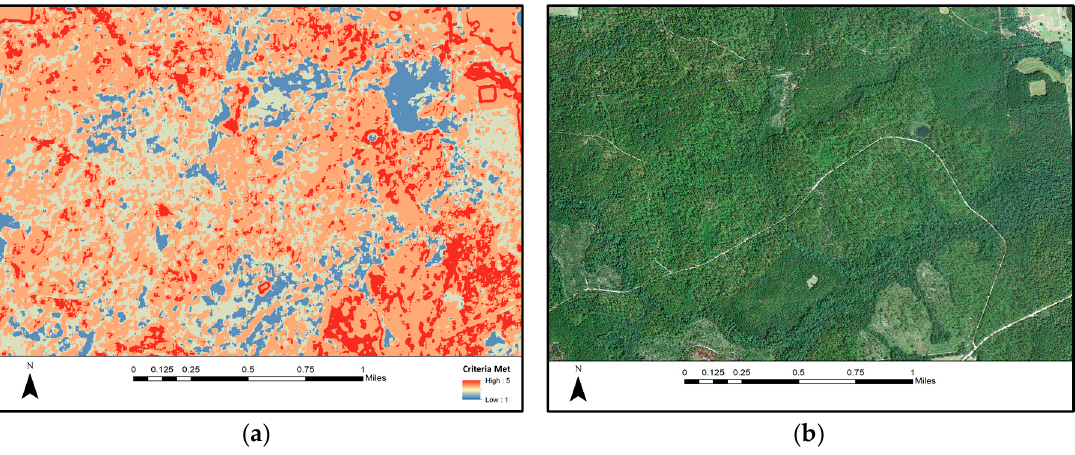
Figure 5. ( a ) Open pine areas prioritized for conservation based on percent cover within a 30 m window. Colors correspond to the number of criteria met. The criteria are: pine cover between 3–30%, shrub plus grass cover greater than 20%, crop cover less than 20%, building plus pavement cover less than 20%, and water cover less than 25%; ( b ) NAIP imagery for the same extent.